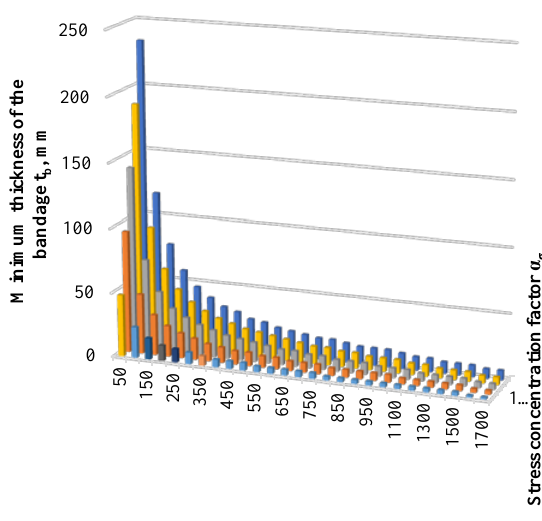
Fig. 4. Dependence of the thickness of the band on the selected material at different values of the stress concentration